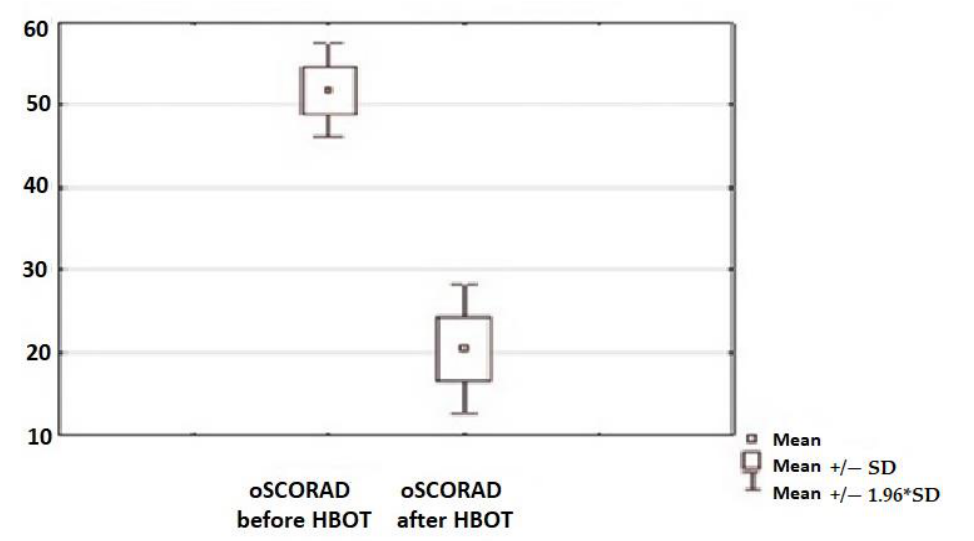
Figure 2. Assessment of the disease activity before and after hyperbaric oxygen therapy (HBOT) with the use of the SCORAD method ( p < 0.05).